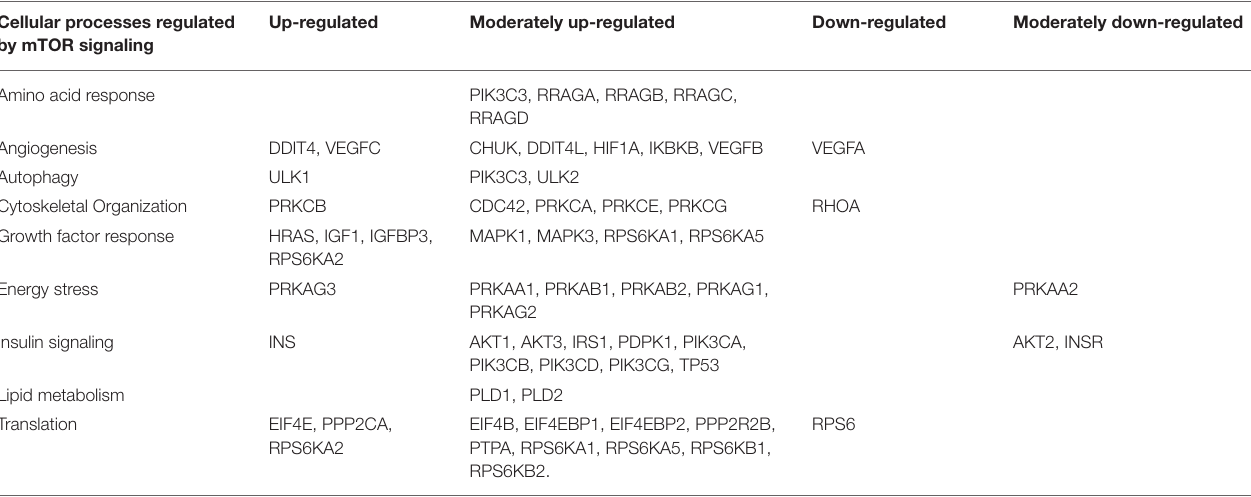
TABLE 5 | Cellular processes regulated by mTOR signaling and differential expression genes between patients with rejection ( + DSA/ + AMR) and without rejection ( + DSA/–AMR and –DSA/–AMR). Cellular processes regulated by mTOR